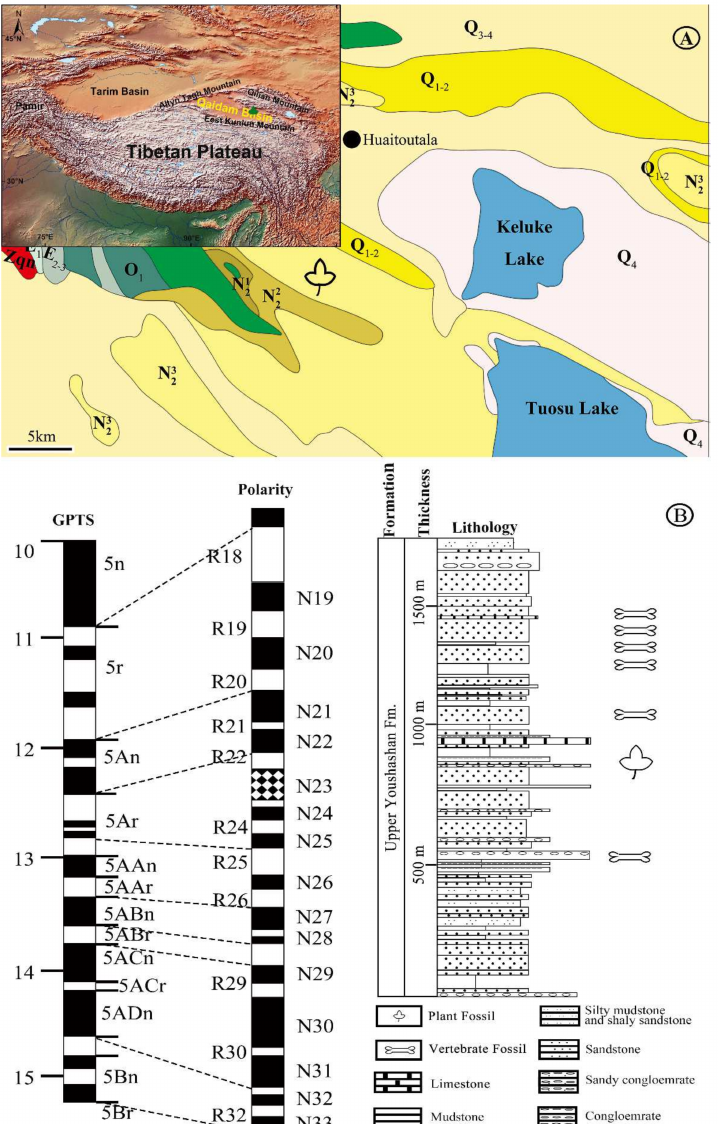
Figure 1. Geological setting of the fossil locality (modified from Li et al. [38]). ( A ) Maps showing the fossil location. ( B ) Stratigraphic column of the studied section. This is located in the lower to the middle part of Upper Youshashan Fm. Shown are the magnetostratigraphic correlation, the chronology and the lithology of the studied section, as well as the chronologic and stratigraphic position of the plant fossil